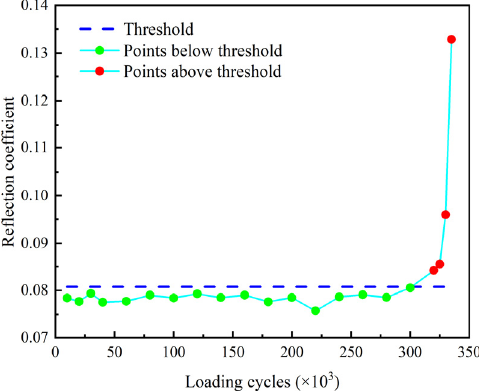
Figure 26. Reflection coefficient R f of filtered echo signal.